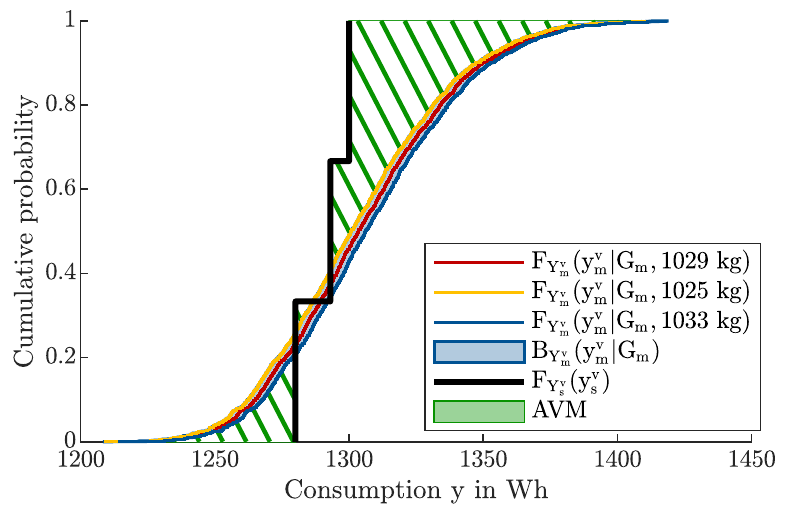
Figure 7. Area Validation Metric AVM calculated from the uncertain simulation output y v m of the model G m and the uncertain system measurements y v s